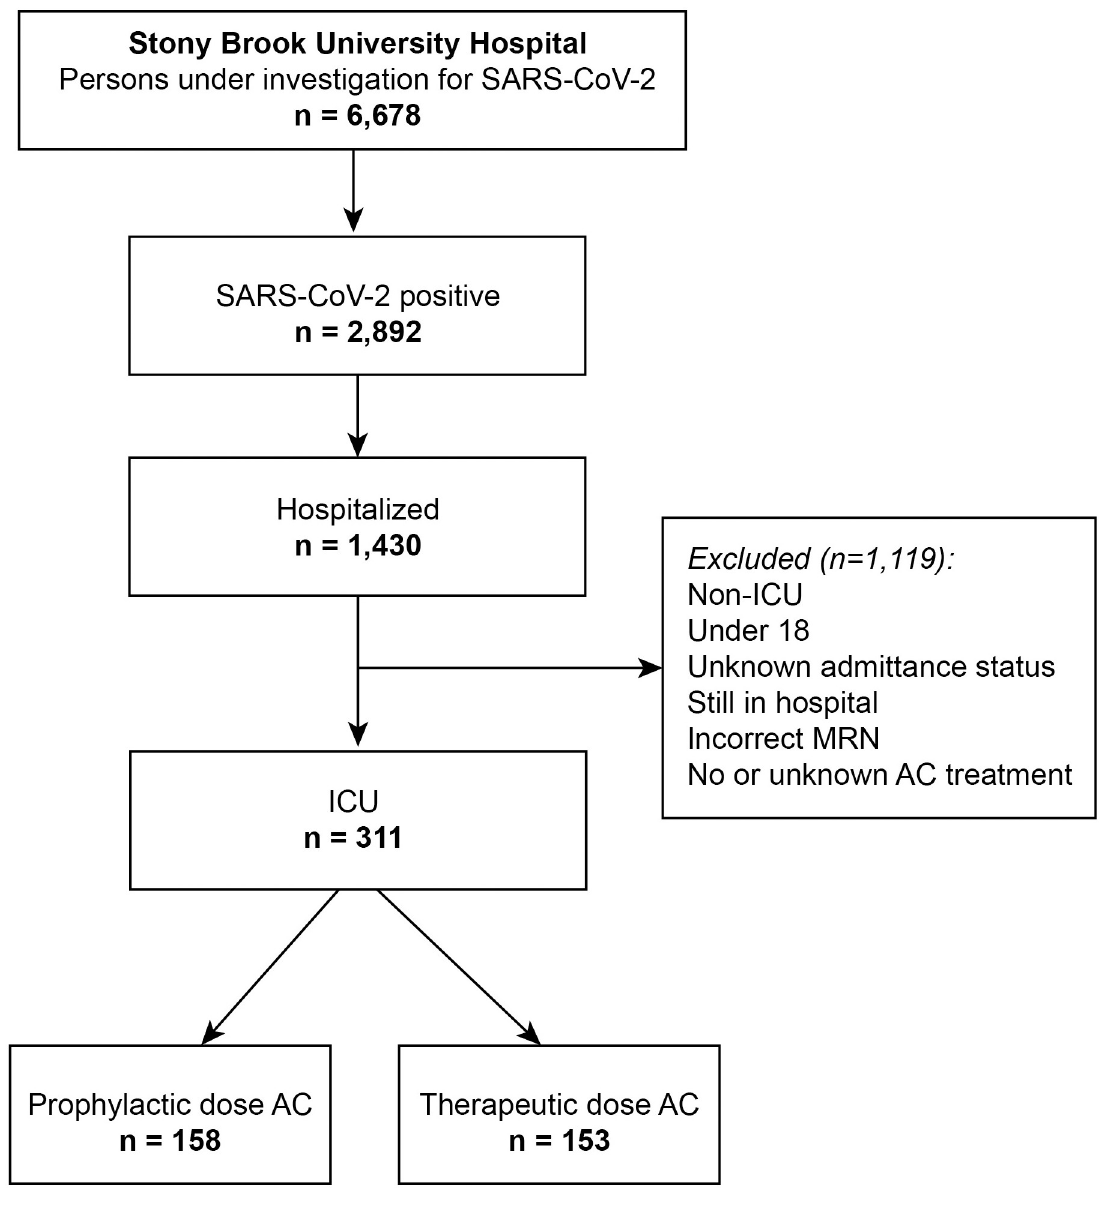
Fig 1. Patient selection